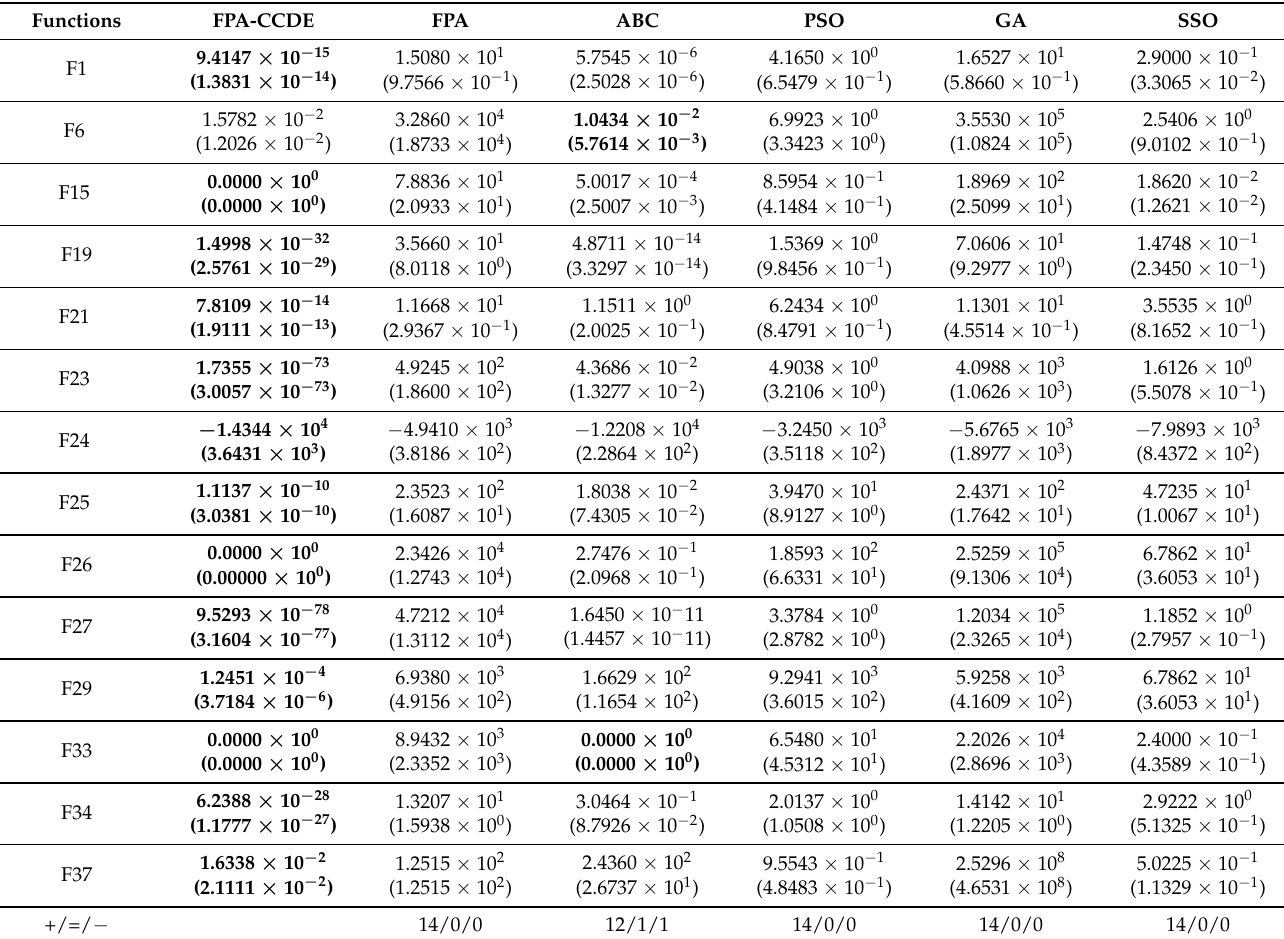
Table 3. Experimental results of benchmark function with high